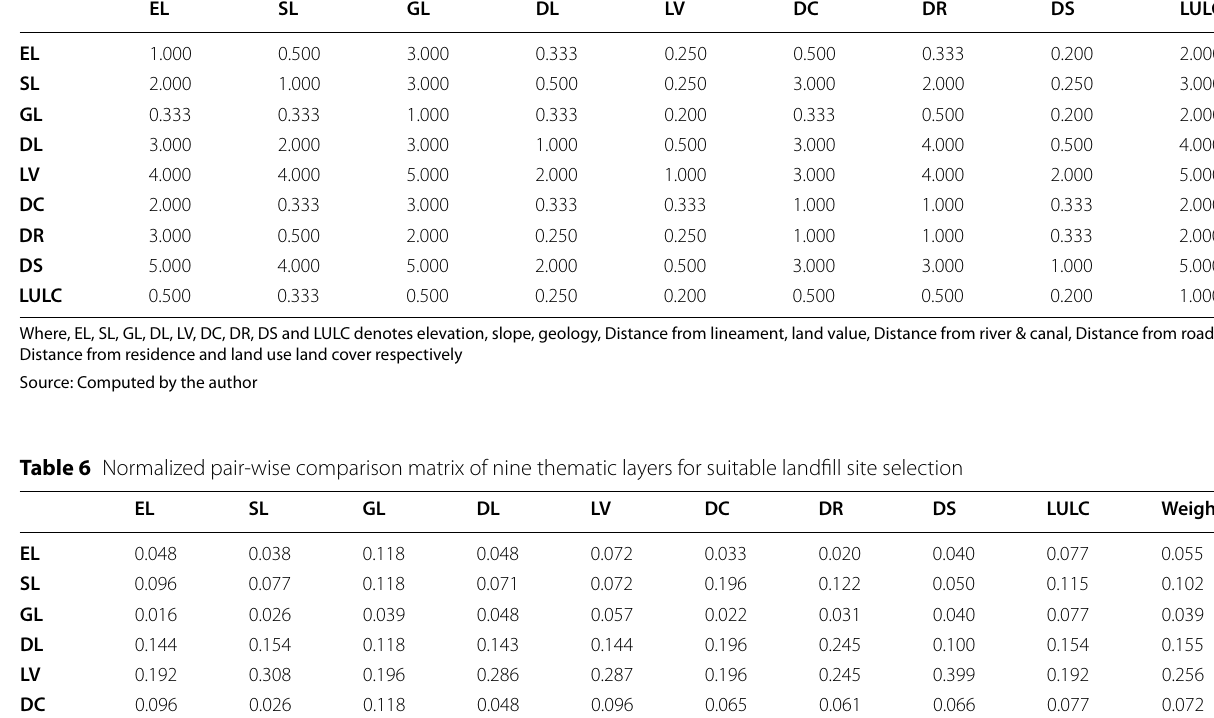
Table 5 Pairwise comparison matrix of nine thematic layer for landfill site selection